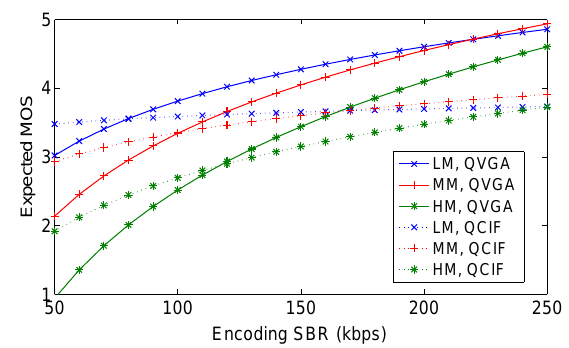
Figure 2. Evolution of expected MOS vs. SBR per CT and